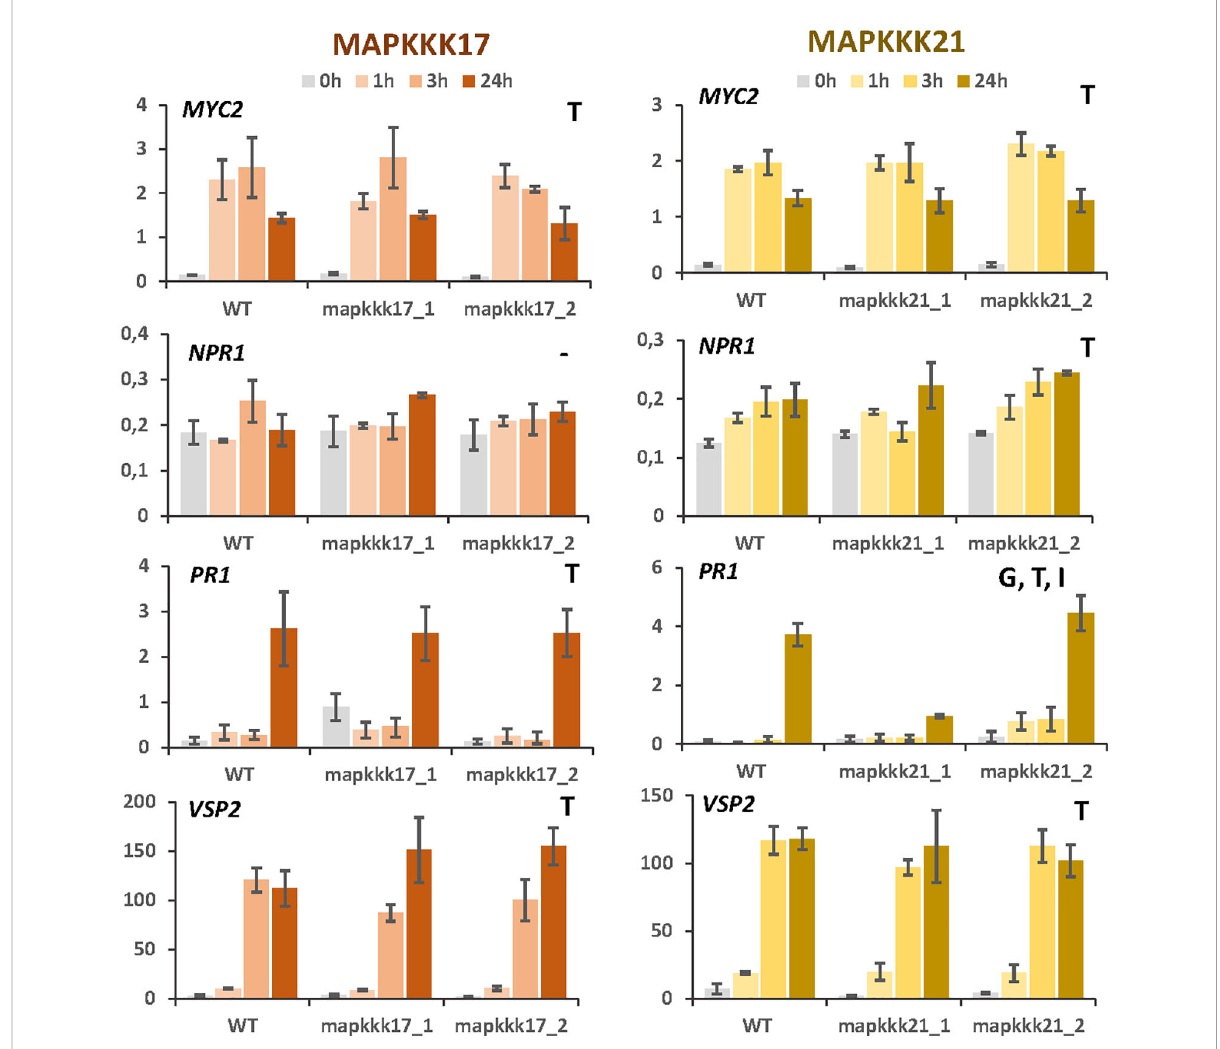
FIGURE 5 Relative expression of MYC2 , NPR1 , PR1 , and VSP2 genes in different Arabidopsis backgrounds. Gene expression was quanti fi ed by RT-qPCR after 1h, 3h, and 24h of mite feeding on WT and T-DNA mutant lines. Data are means ± SE of three biological replicates. Signi fi cant factors (SF) indicate whether the two independent factors, T (treatment with mites) and G (genotype), and/or their interaction, I (T×G), were statistically signi fi cant (Two-way ANOVA, P<0.05, followed by Student-Newman-Keuls multiple comparisons